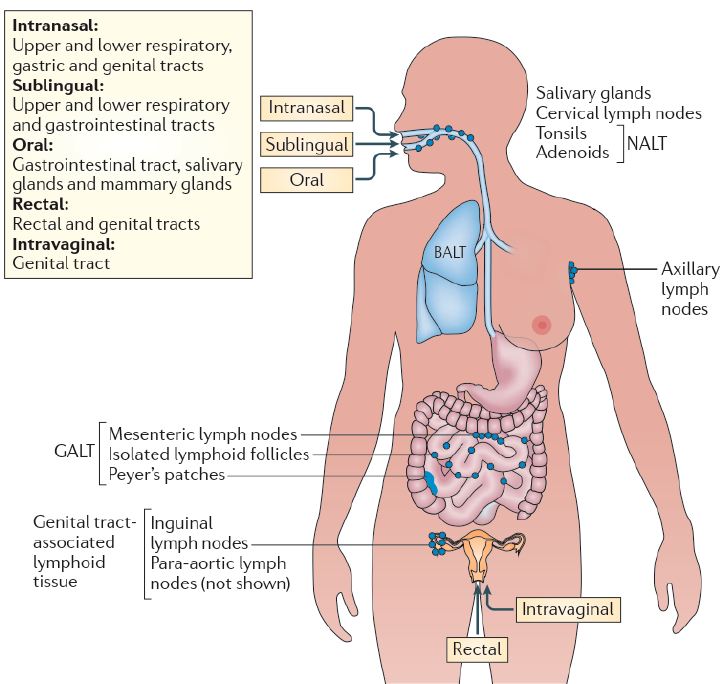
Figure 2. Mucosal immunization routes and compartmentalization of effector functions. Within the mucosa-associated lymphoid tissue (MALT), sub compartments can be identified, such as the nasopharynx-associated lymphoid tissue (NALT), bronchus-associated lymphoid tissue (BALT), gut-associated lymphoid tissue (GALT) and genital tract-associated lymphoid tissue. Certain immunization routes are more effective at stimulating immunity within specific, most often closely located, sub compartments of the MALT. Intranasal vaccination is preferred for targeting the respiratory, gastric and genital tracts; oral vaccination is effective for immunity in the gut and for the induction of mammary gland antibodies (which are secreted in milk); rectal immunization is best for the induction of colon and rectal immunity and to some extent genital tract immunity; and intravaginal vaccination is the most effective for antibody and T cell immunity in the genital tract. (Reprinted with permission from Ref. [3]).